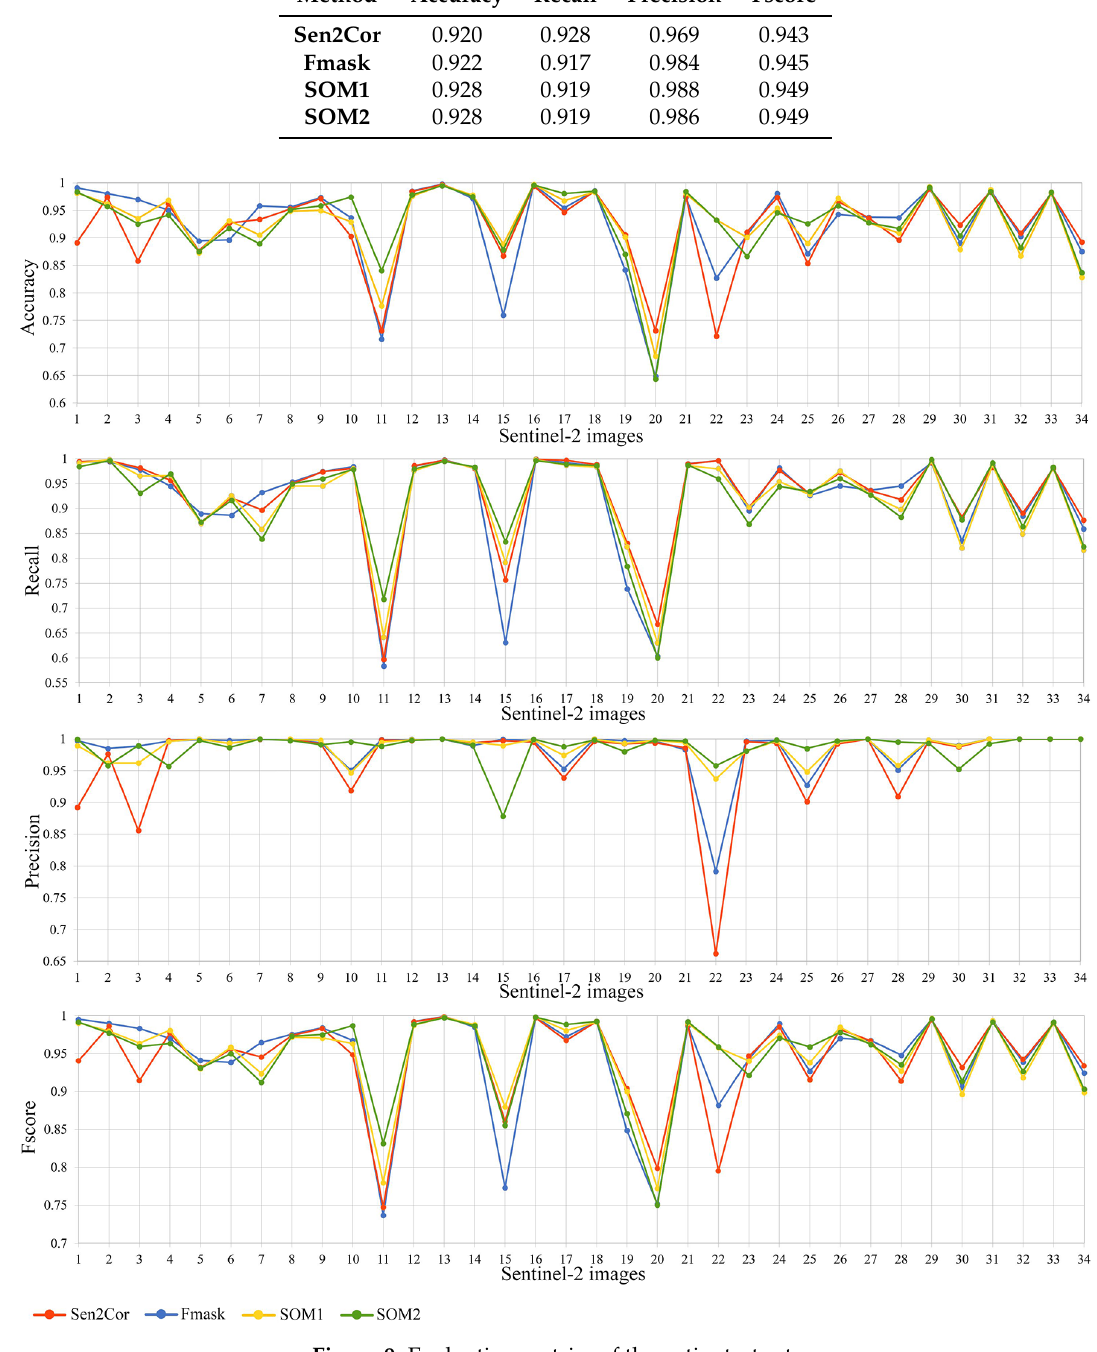
Figure 9. Evaluation metrics of the entire test